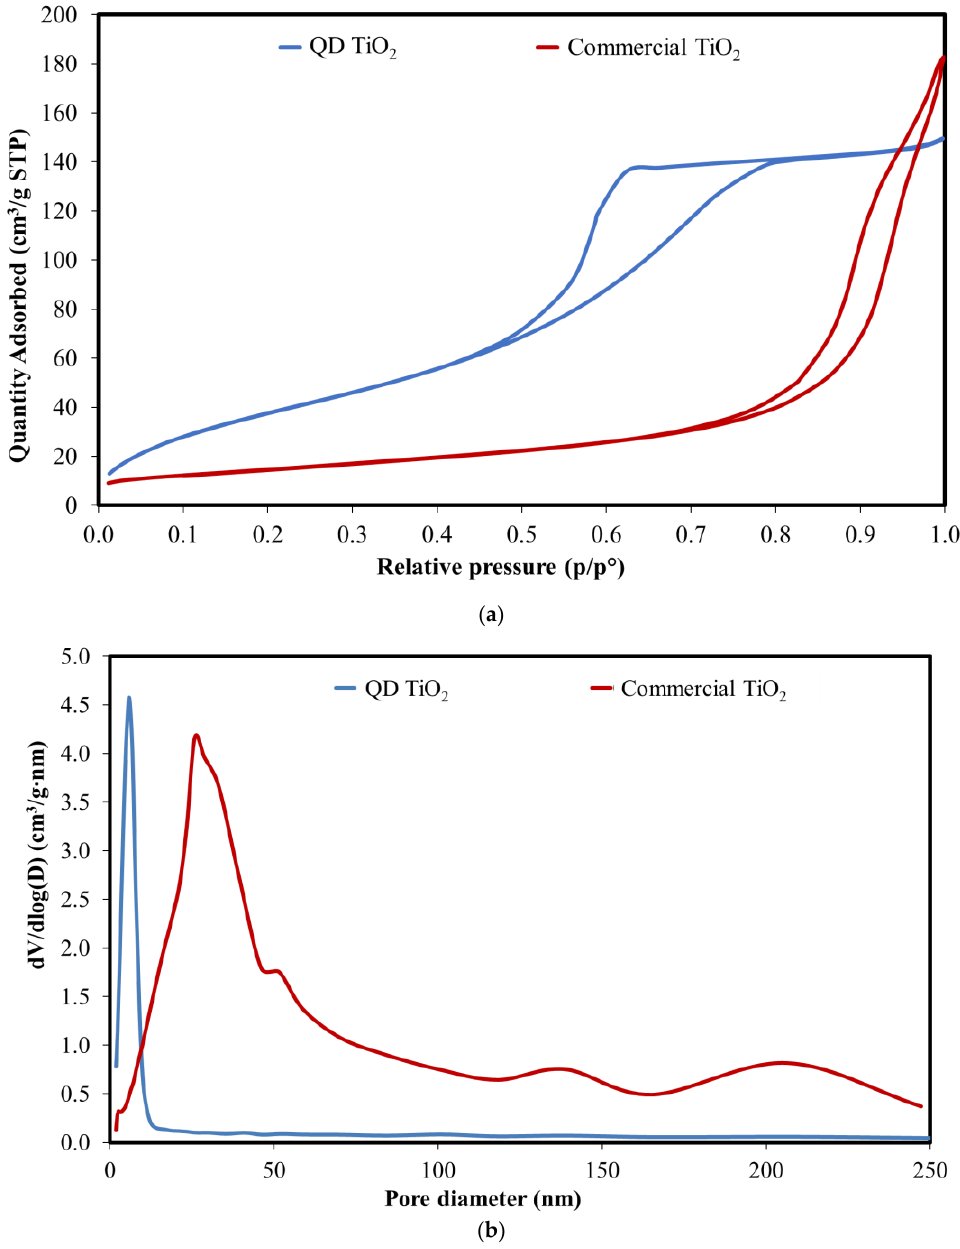
Figure 3. The ( a ) absorption – desorption isotherm and ( b ) pore size distribution of the synthesized QD TiO 2 and commercial TiO 2